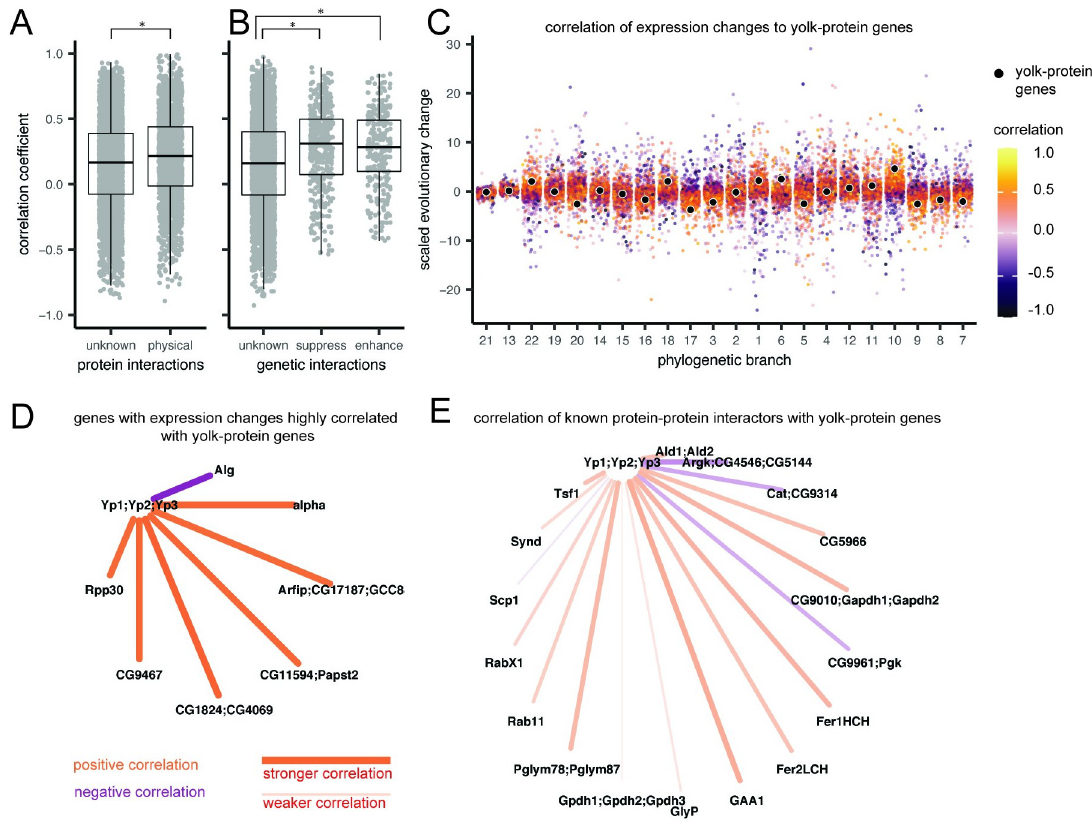
Fig 5. Estimating pairwise correlation coefficients across genes reveals new networks of correlated expression evolution. A-B Comparison of the distribution of Pearson’s correlation coefficients based on ovary-biased expression evolution between genes. Box plots indicate mean, upper and lower quartiles, and 1.5x interquartile ranges. Asterisks indicate a significant t-test comparison. A, Genes with no or unknown protein-protein interactions compared to those with reported interactions in FlyBase [52] (maximum p-value = < 0.001 over 100 replicates). B, Correlation comparison between genes with no or unknown genetic interactions and those reported to have enhancement or suppression interactions in FlyBase (unknown vs. enhancement max. p-value = < 0.001; unknown vs. suppression max. p-value = < 0.001; enhancement vs. suppression p-value = 0.497). C, Each point represents a scaled change in expression bias, colored by Pearson’s correlation coefficients relative to one example gene-family, the yolk-protein genes (black points), arranged by phylogenetic branch (numbers shown in Fig 4D). Yellow = strong positive correlation, purple = strong negative correlation. D, The network of strong correlation partners (absolute correlation > 0.825) with the yolk-protein genes, colored by the direction of correlation. Stronger correlations are shown by brighter colors, and thicker, shorter lines. Nodes are annotated with the gene symbols from the D. melanogaster sequences from that homology group. E, The correlation between known protein-protein interaction partners [52] with the yolk-protein